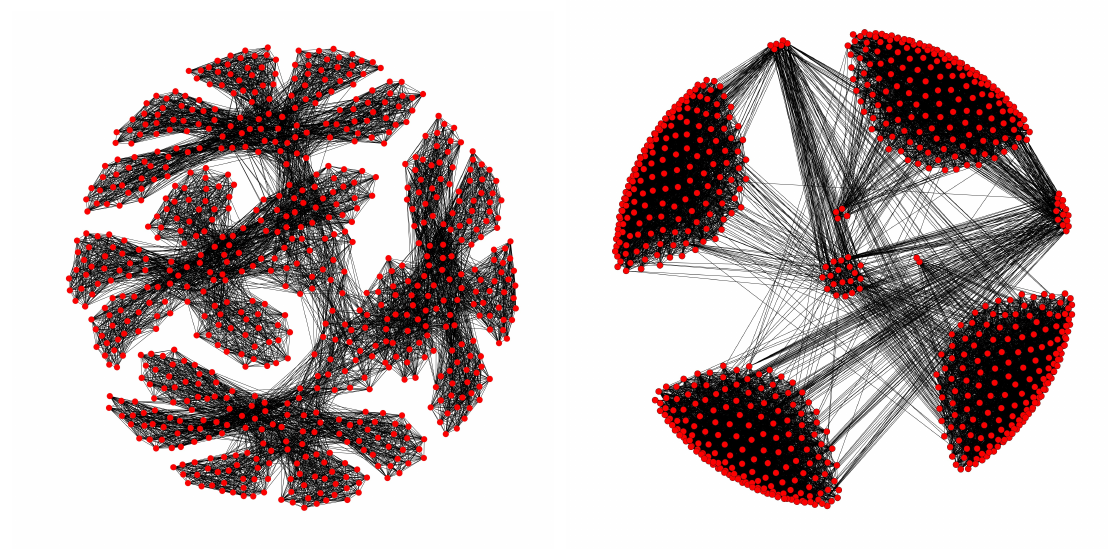
Figure 6. ( Left ): Original graph extracted from the density matrix for the phenyl dendrimer molecular structure. Note the fractal-like structure of the graph. ( Right ): Rearranged graph by the partitions resulting from the METIS + SA algorithms. Only edges with weights larger than 0.01 were kept to ease